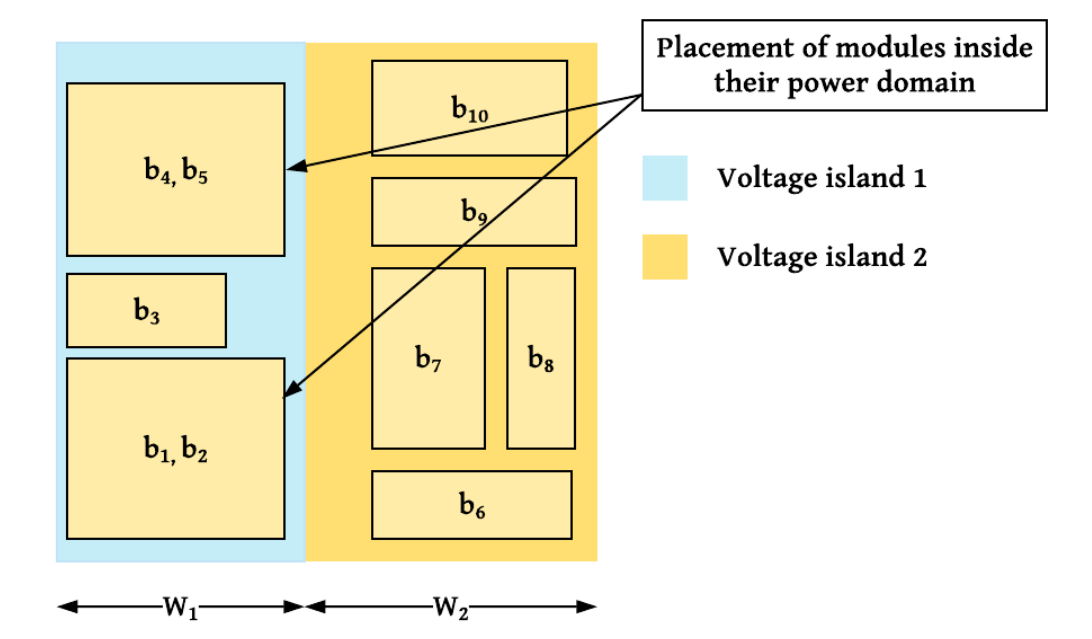
Figure 5. Placement of modules in the power